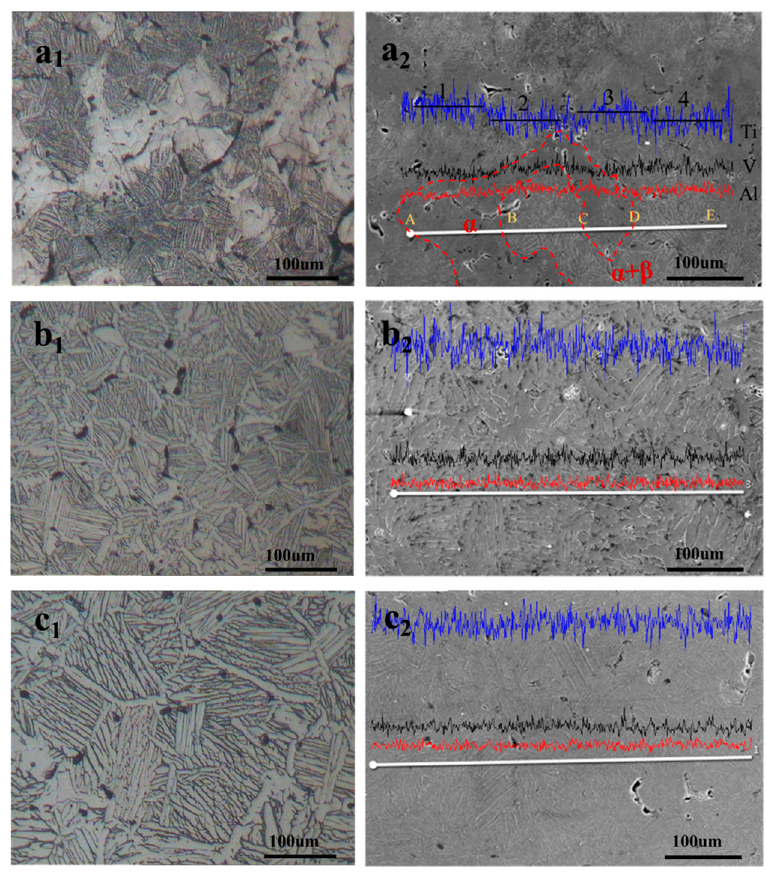
Figure 2. OM ( a 1 , b 1 , c 1 ) and SEM ( a 2 , b 2 , c 2 ) images of PM TC4 alloy when sintered at ( a 1 , a 2 ) 1100 °C, 3 h, 7.5 min/°C; ( b 1 , b 2 ) 1200 °C, 3 h, 7.5 min/°C; ( c 1 , c 2 ) 1300 °C, 3 h, 7.5 min/°C. 3 h, 7.5 min/ ◦ C; ( b ◦ C, 3 h, 7.5 min/ ◦ C; ( c ◦ C, 3 h, 7.5 min/ ◦ 1 , b 2 ) 1200 1 , c 2 ) 1300